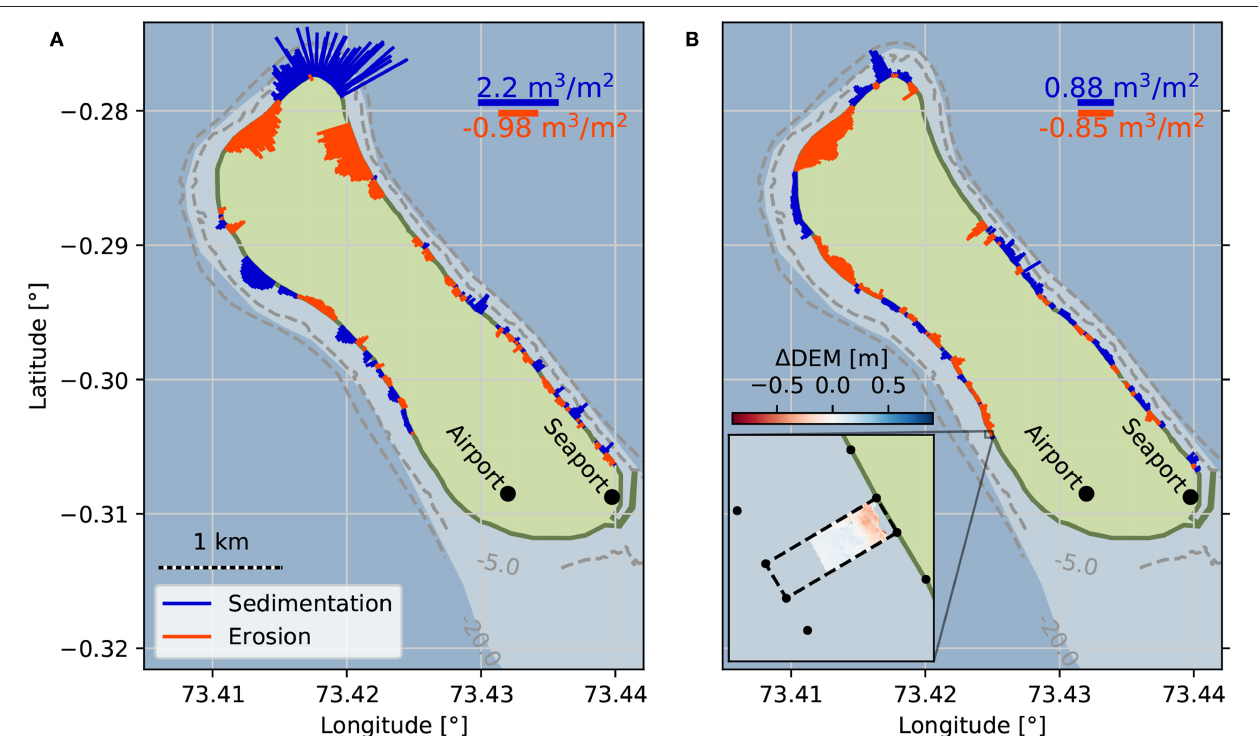
FIGURE 3 | Average areal sediment budgets from DEMs with (A) seasonal sediment budget from dry to wet season, based on the data of March 2017 and September 2017 and (B) annual sediment budget between dry season 2017 and 2019 (both recorded in March). In both subfigures, sediment accumulation for the observation period is blue, while sediment removal is red. The volumetric change of sediment [m 3 ] is averaged over dry beach area [m 2 ] (see Equation 4). Bathymetry lines (gray, dashed) come from measurements in the first field campaign (March